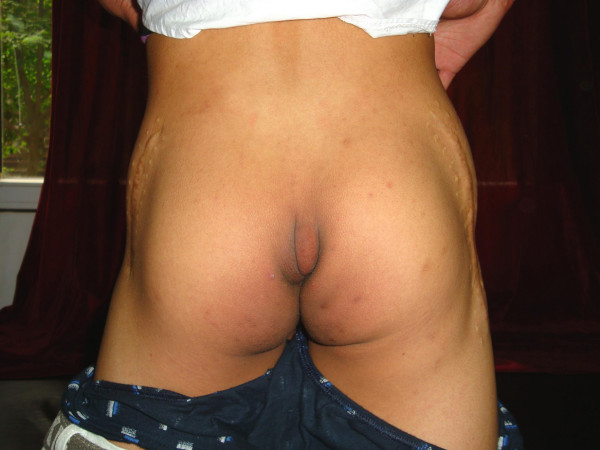
Level II patient form figure 2, The abduction contracture angle is 45° with both hip and knee joint in 90°. This patient came to our hospital for the second surgery due to the incomplete release of the contraction band in the other hospital. The huge scaring in the incision can also been seen.